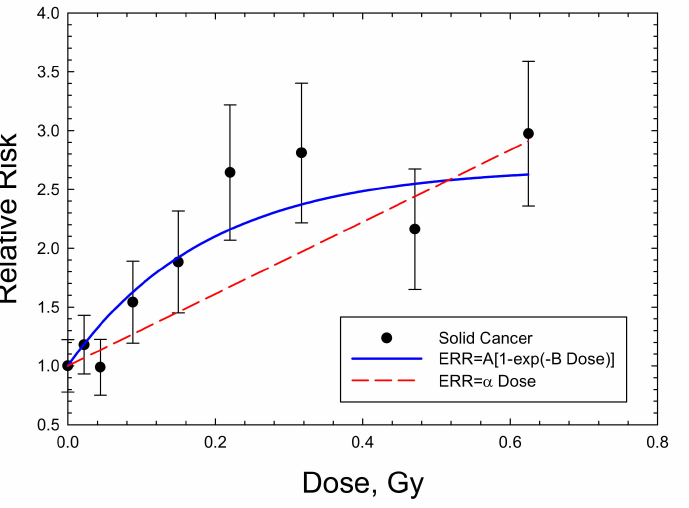
Figure 5. Dose response for relative risk of solid cancers in male B6CF1 mice exposed to fission neutrons (mean energy 0.4 MeV). The saturable ERR model described in the text is compared to the experimental data of